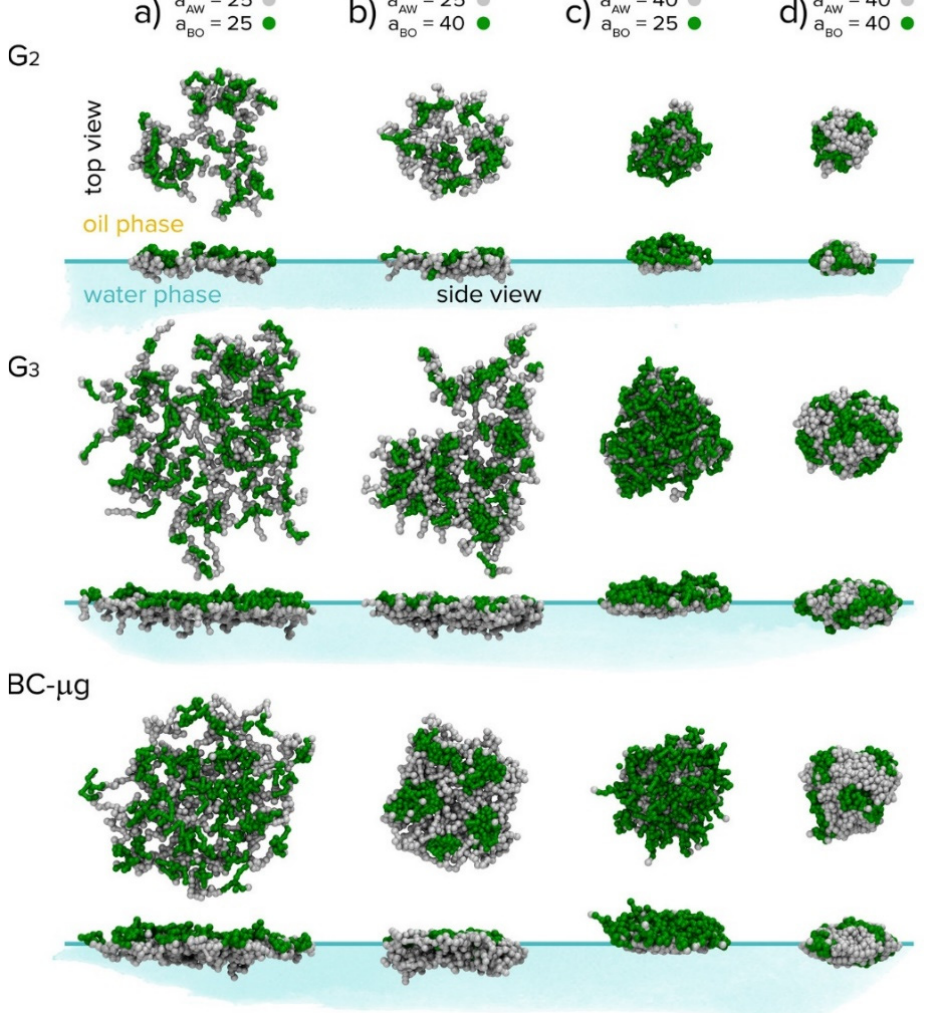
Figure 12. Snapshots of single arborescent copolymers and block copolymer microgel adsorbed at the interface of two immiscible liquids. ( a ) First column corresponds to the case when the upper (oil) and bottom (water) liquids act as good solvents for the green (B) and the grey (A) beads, respectively, and vice versa ( a AW = a BO = 25, a AO = a BW = 40). ( b ) Second column shows the regime when water is a good solvent for the A beads, poor solvent for the B beads and oil is a poor solvent for both polymeric beads ( a AW = 25, a BO = 40). ( c ) The third column represents the swelling of minor (B) component in the oil ( a BO = 25, a AW = 40). Finally, ( d ) the fourth column demonstrates deformation of the molecules insoluble in both liquids ( a AW = a BO = 40). (Reprinted with permission ACS from Appl. Mater. Interfaces 2017 , 9 , 31302 − 31316, doi:10.1021/acsami.7b00772. Copyright 2021 American Chemical